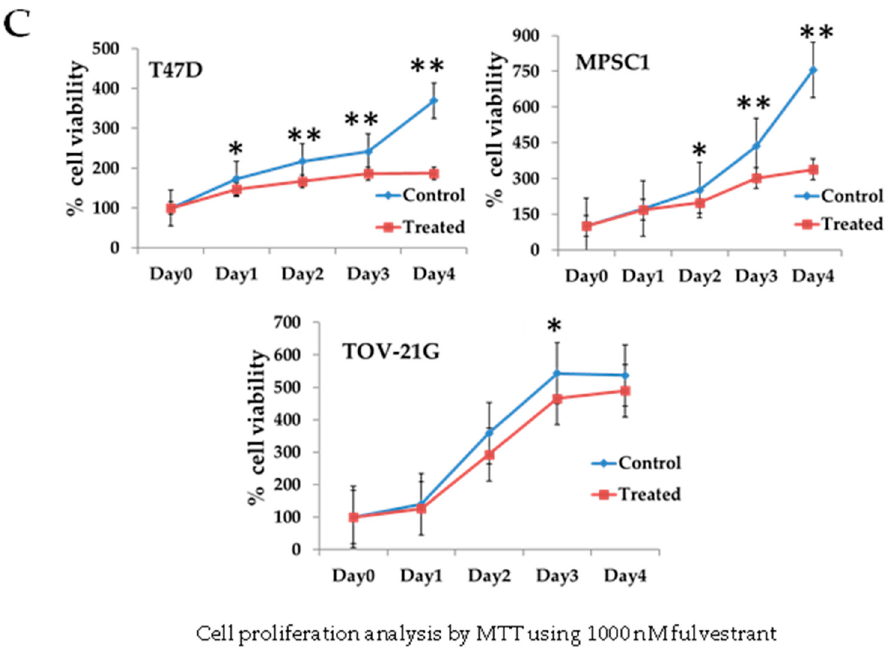
Figure 3. Cell proliferation analysis using fulvestrant in MPSC1, T47D, and TOV-21G cell lines. Different fulvestrant concentrations: ( A ) 10 nM; ( B ) 100 nM; and ( C ) 1000 nM. MTT assays in the T47D and MPSC1 cell lines showed significant (* p < 0.05; ** p < 0.01) growth inhibiting ability compared to that in the control cell line. The experiment was conducted in triplicate, and data are presented as mean ± standard deviation. MTT, 3-(4,5-dimethylthiazol-2-yl)-2,5-diphenyl tetrazolium bromide.